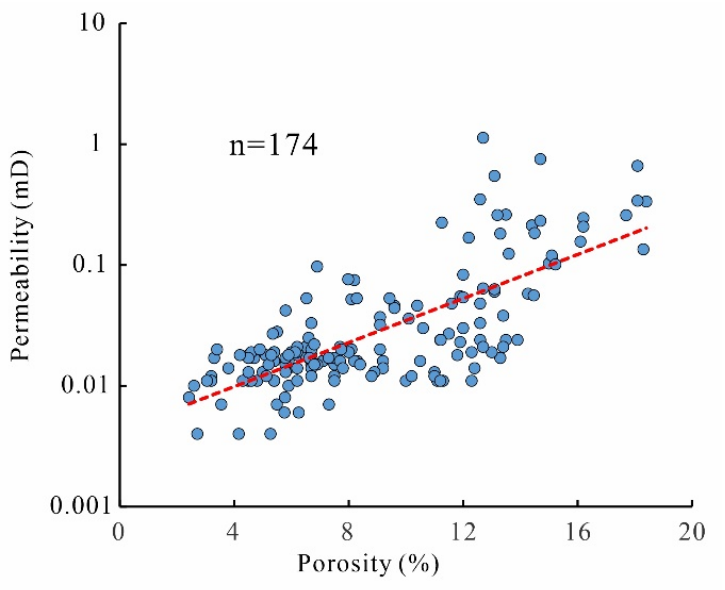
Figure 6. Relationship between porosity and permeability of the Permian Lucaogou Formation. Table 1. XRD analysis of reservoir rocks in the Lucaogou Formation of Jimsar Sag.